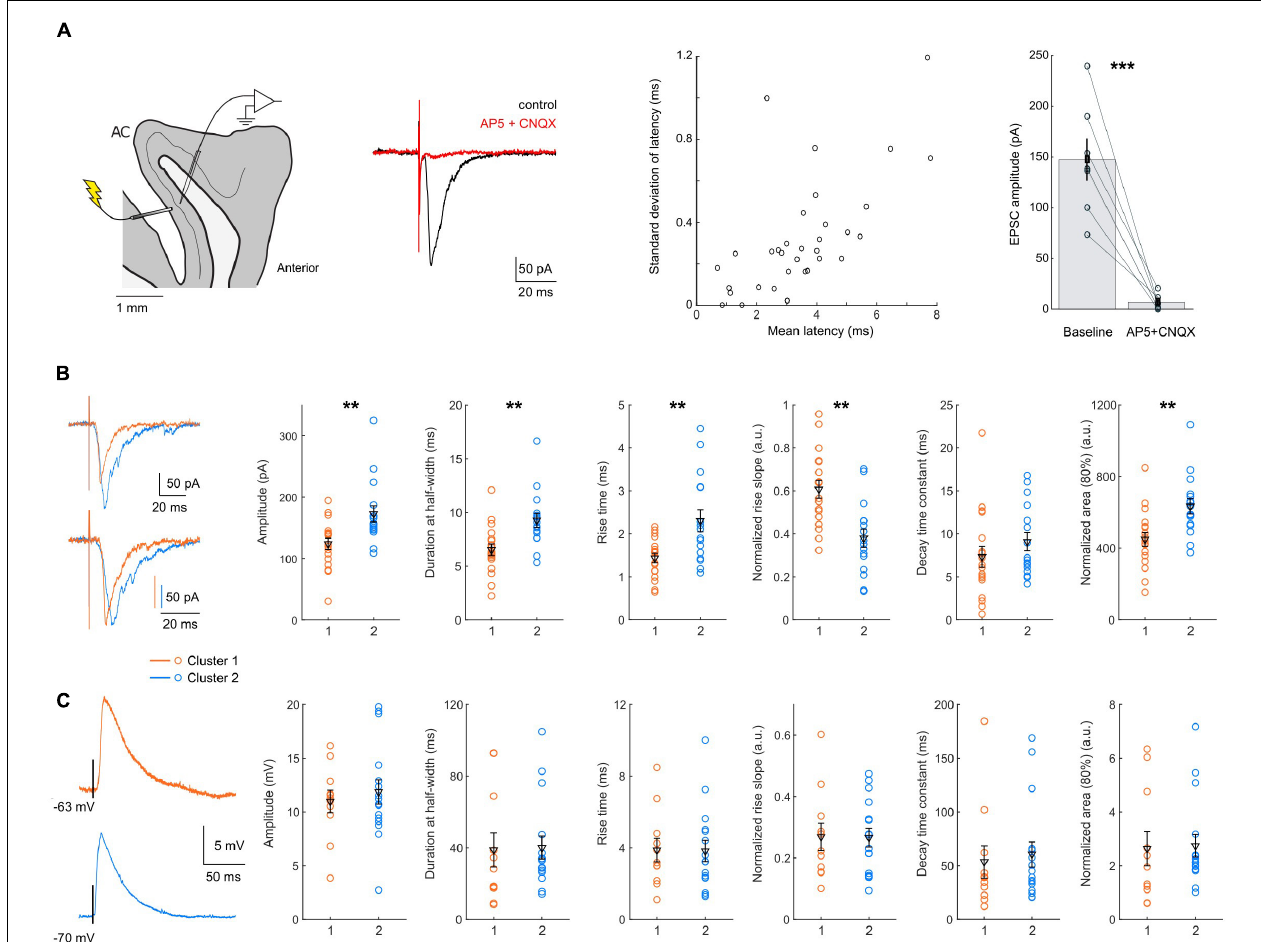
FIGURE 4 | Subthreshold responses to FEF L2/3 stimulation. (A) Left: diagram of the experiment configuration, and example EPSCs evoked by layer 2/3 stimulation, under control conditions (black) or in the presence of glutamate blockers (red). Center: scatter plot of the latency and SD of the latency of the responses in each cell tested ( n = 34). Right: bath application of glutamate transmission blockers suppressed the response to layer 2/3 stimulation. (B) Left: example of single EPSCs recorded in cluster 1 (orange) and cluster 2 (blue) neurons, with (bottom) or without (top) amplitude normalization; Right: scatter plots of EPSC properties, with mean and SEM indicated in black. Cluster 1 neurons had EPSCs of smaller amplitude ( p = 0.0023) and area ( p = 0.0025), with faster kinetics: a shorter duration ( p = 0.0018), shorter rise time ( p = 0.0083) and faster normalized rise slope ( p = 0.0011). (C) Left: example of single EPSPs recorded in cluster 1 (orange) and cluster 2 (blue) neurons. Right: scatter plots of EPSP properties, with mean and SEM indicated in black. No significant difference was detected between the EPSP properties of the two clusters. All data: mean ± SEM. * p < 0.05; ** p < 0.01; *** p <